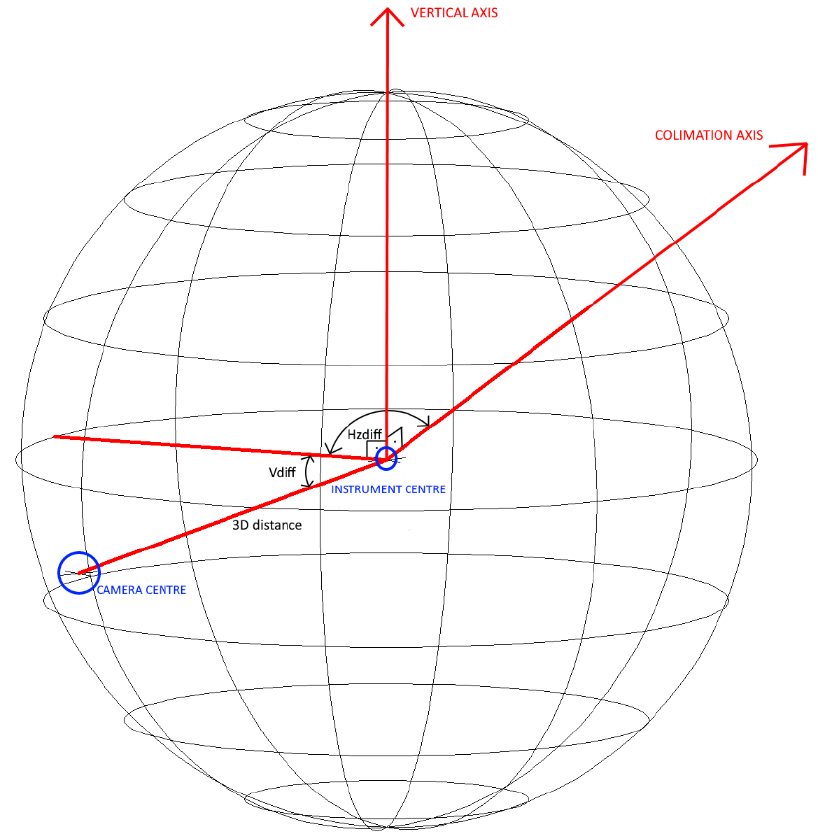
Figure 6. Camera and instrument center geometric relation (Source: Own compilation).